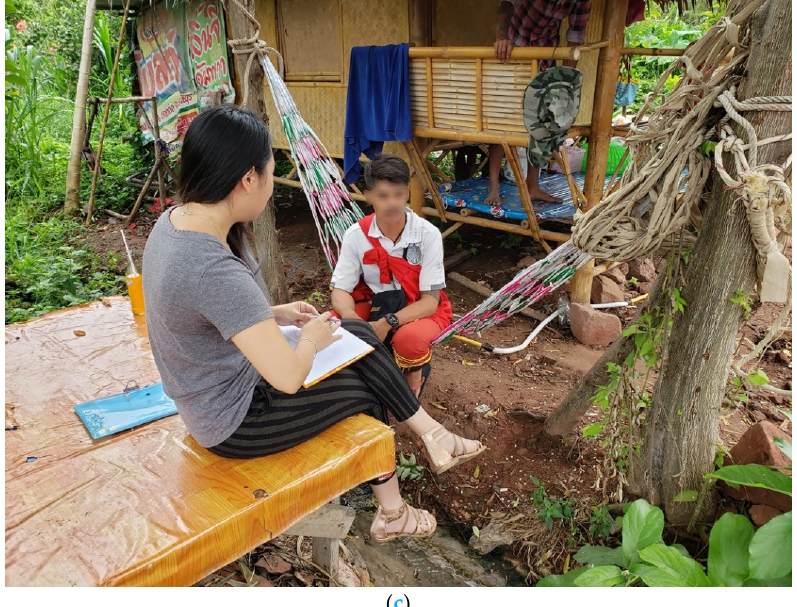
Figure 1. ( a ): A traditional annual ‘Shrine of Household God Worship’ ceremony. The elephants are offered sugarcane, banana, mango, and various types of food and worshiped by the local villagers. ( b ): Uncle ‘Ju’ (a senior mahout) is giving ‘Boon Nim’ a bath every morning after her breakfast. Boon-Nim is a retired geriatric elephant who has lost all her teeth. To prepare for her meal, Napier grass and sugarcane are ground up before mixing with feed pallets, tamarind paste, rock salt, and supplementals. ( c ): The interviewer was accepted at the workplace. A hut in the background is a house provided by the sanctuary.